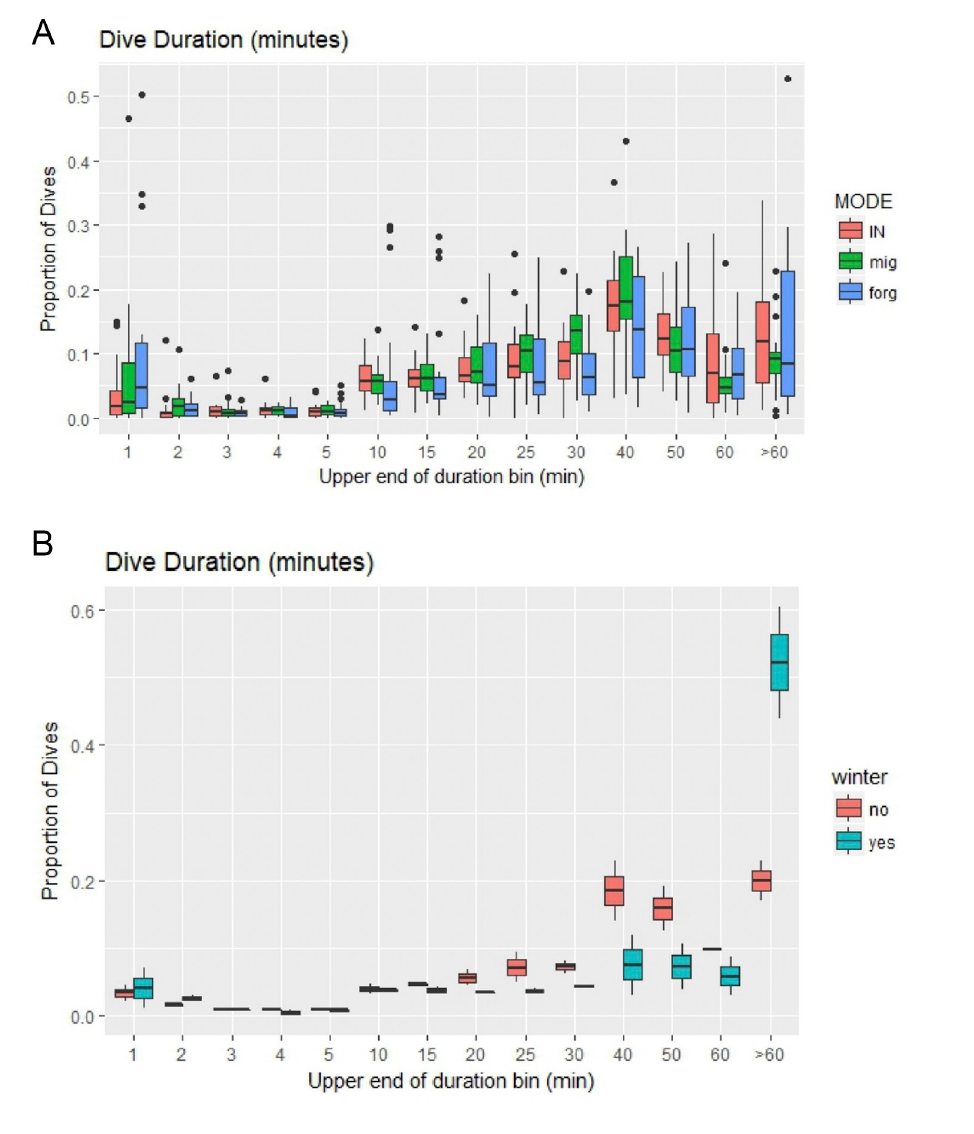
Fig 4. Boxplots for dive duration histograms for adult female loggerhead turtles ( Caretta caretta ) in the Gulf of Mexico. Proportions of dive durations (A) represent per turtle and per mode values with the dives per bin divided by the total dives for each mode. The lower panel (B) shows the proportions for the two turtles that had dive information in the winter. Values are only for foraging periods and proportions were created for each bin for dives in winter (“yes”, 21 December– 21 March) or not